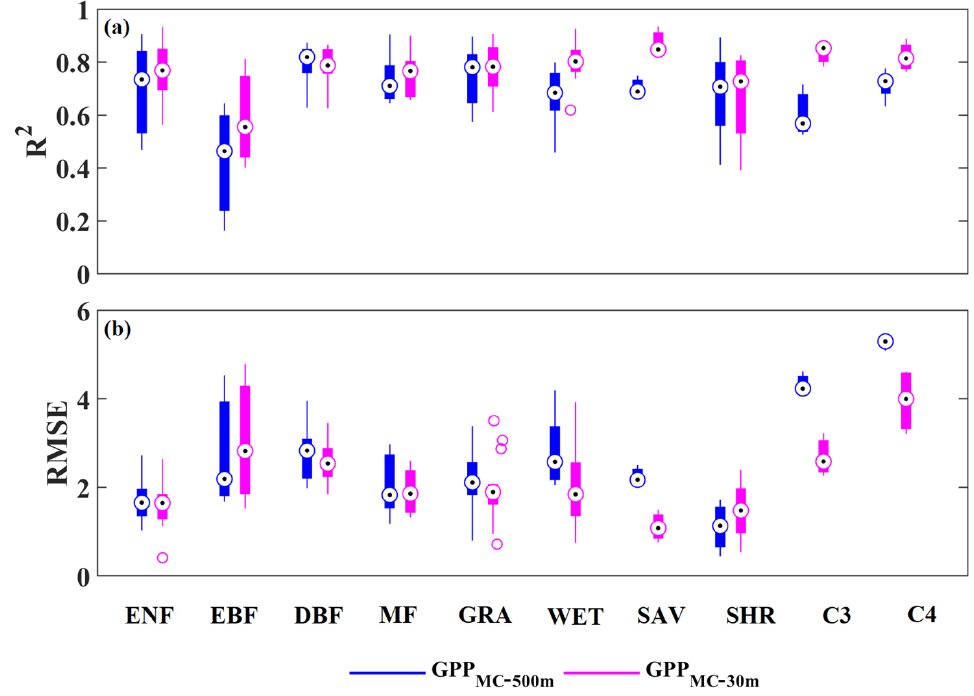
Figure 6. Boxplots of the values of the R 2 ( a ) and RMSE ( b ) for GPP MC-30m , GPP MC-500m , and site GPP (GPP EC ) at the 78 sites with 10 vegetation types. The calculation of GPP MC-30m and GPP MC-500m used the same meteorological data (temperature, VPD, air atmospheric pressure, and CO 2 concentration) as driving data for fair comparison; the only differences between GPP MC-30m and GPP MC-500m are the optimized parameters and NDVI, with footprint sources at different spatial resolutions.